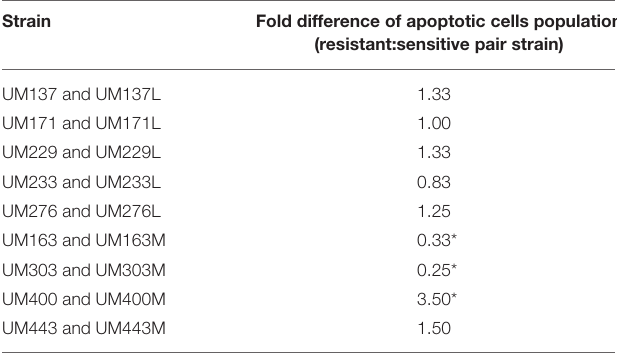
TABLE 2 | Fold differences of the apoptotic AGS cells population induced by H. pylori from the ratio of resistant and sensitive pair strains, post-12 h of